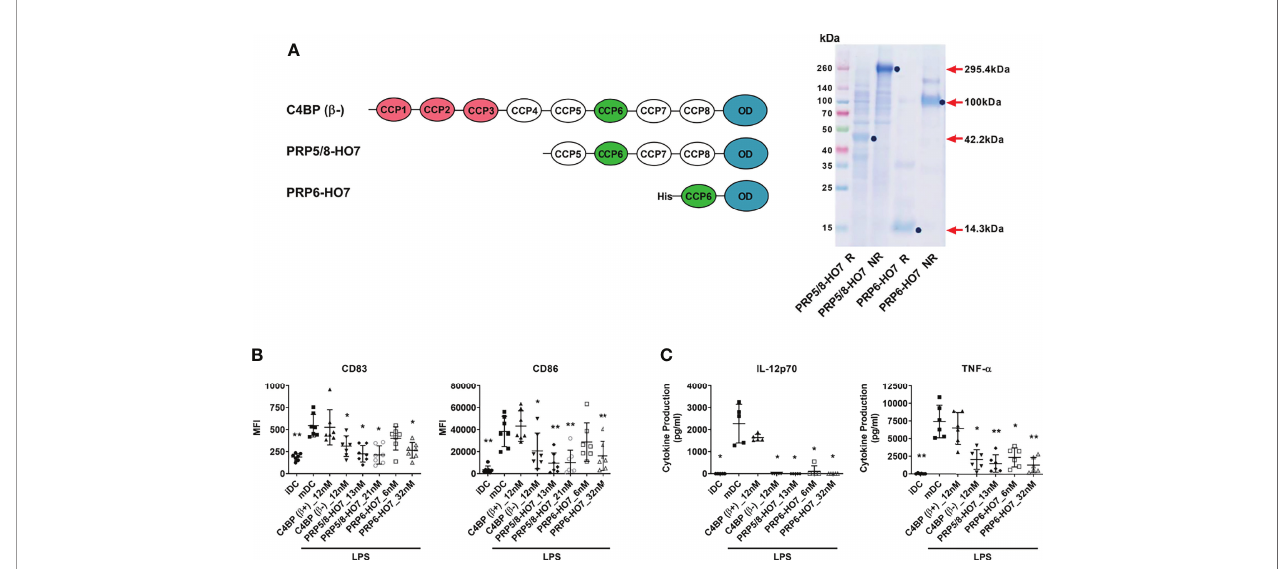
FIGURE 2 | Deletion of the complement inhibitory domains of C4BP( b -) does not affect its immunomodulatory activity. (A) Left: Schematic structure of the a -chains from C4BP( b − ), and from its variants PRP5/8-HO7 and PRP6-HO7. The CCP1-CCP3 complement inhibitory domains are depicted in red. The CCP6 immunomodulatory domain is depicted in green. The oligomerization domain (OD) is depicted in blue. “ His ” refers to a poly-histidine tag located at the N-terminus of PRP6-HO7. Right: SDS-PAGE and Coomassie Blue staining of both PRP5/8-HO7 and PRP6-HO7 under reducing (R) and non-reducing (NR) conditions. Red arrows and blue dots indicate the location and size of both reduced and non-reduced protein forms. Left lane, molecular weight marker. (B) Human Mo-DCs were incubated throughout their differentiation process with C4BP( b +), C4BP( b -) (both at 12 nM) and the variants PRP5/8-HO7 and PRP6-HO7 at the indicated concentrations. DC maturation was achieved by LPS treatment. Cells were then collected, washed, and analyzed by fl ow cytometry for cell surface expression of the activation marker CD83 and the co-stimulatory molecule CD86. MFI, median fl uorescence intensity for the different surface markers. (C) The concentrations of IL- 12p70 and TNF- a were analyzed in the respective cell supernatants by ELISA. iDC, untreated, immature DCs; mDC, untreated, LPS-matured DCs. The results shown are the mean ± SD from 7 independent donors (cell surface markers), or from 5-6 independent donors performed in duplicate (cytokines) (*p < 0.05; **p < 0.01 compared with